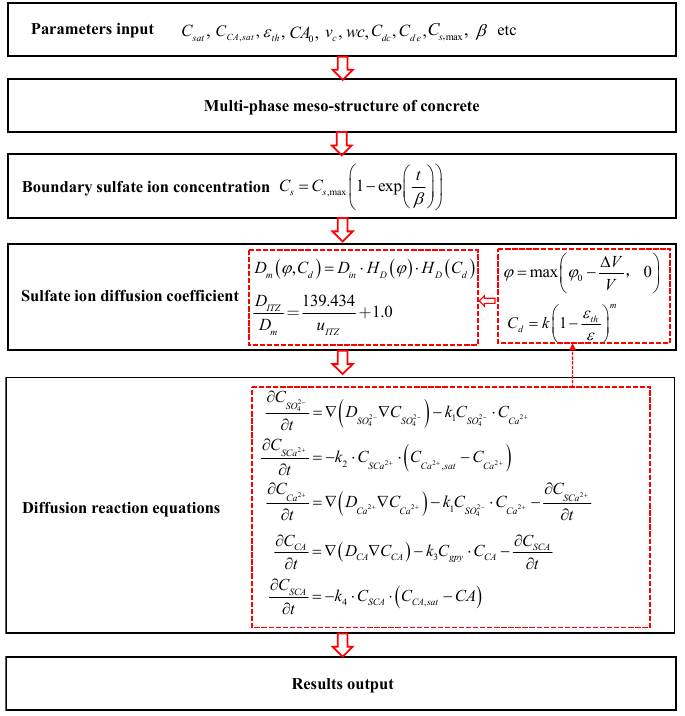
Figure 6. Flow chart of the derivation of the proposed multiphase numerical model.